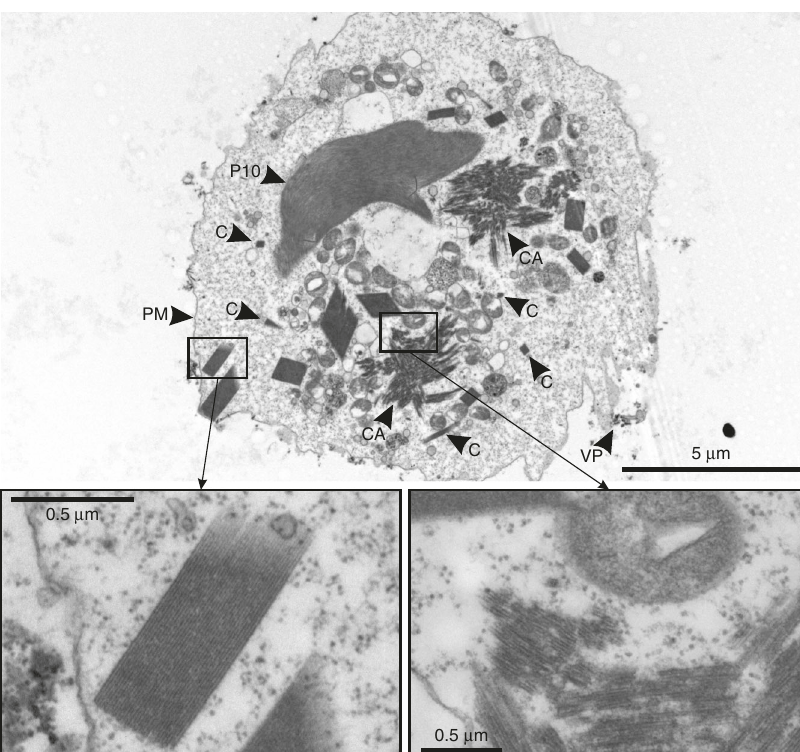
Fig. 2 TEM studies of TbIMPDH crystals. Transmission electron micrograph of a Sf9 cell 6 days p.i. showing multiple TbIMPDH crystals with varying dimensions. Sub-micron crystals are indicated by “ C ” . Signs of infection are clearly visible (baculoviral P10 protein - “ P10 ” , viral particles - “ VP ” ). TbIMPDH not only crystallizes in needle-shaped crystals characterized by a regular crystal lattice (left inset), but also seems to create irregular crystalline assemblies ( “ CA ” , right inset) that display fragmented crystal lattices and spread over several µ m within the cytoplasm. PM plasma